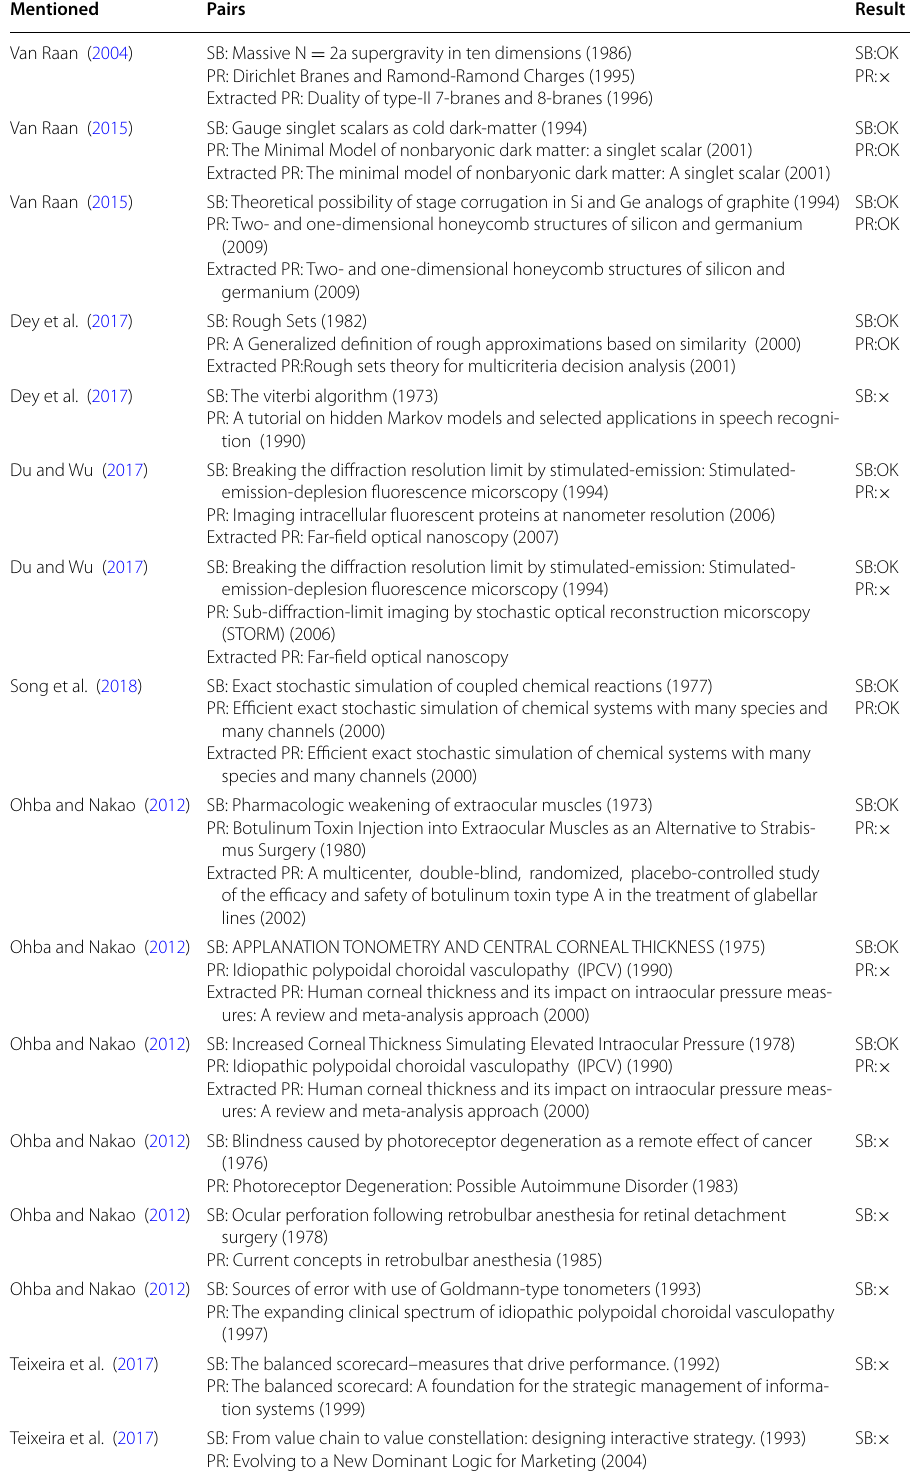
Table 12 Validation results of SB–PR